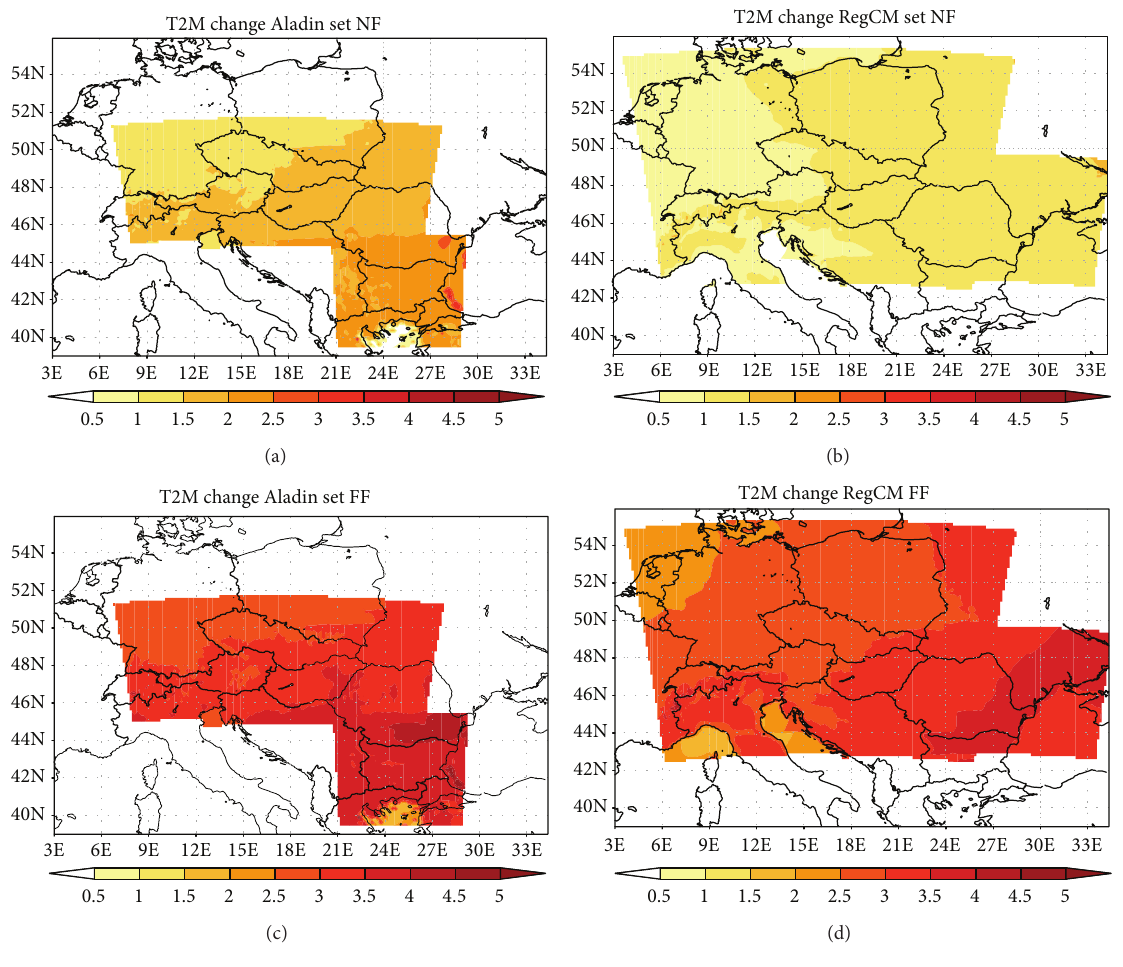
Figure 2: Change in annual 2 m temperature in Aladin (a, c) and RegCM (b, d) set between 2021–2050 and 1961–1990 (a, b) and 2071–2100 and 1961–1990 (c, d). Units are ∘